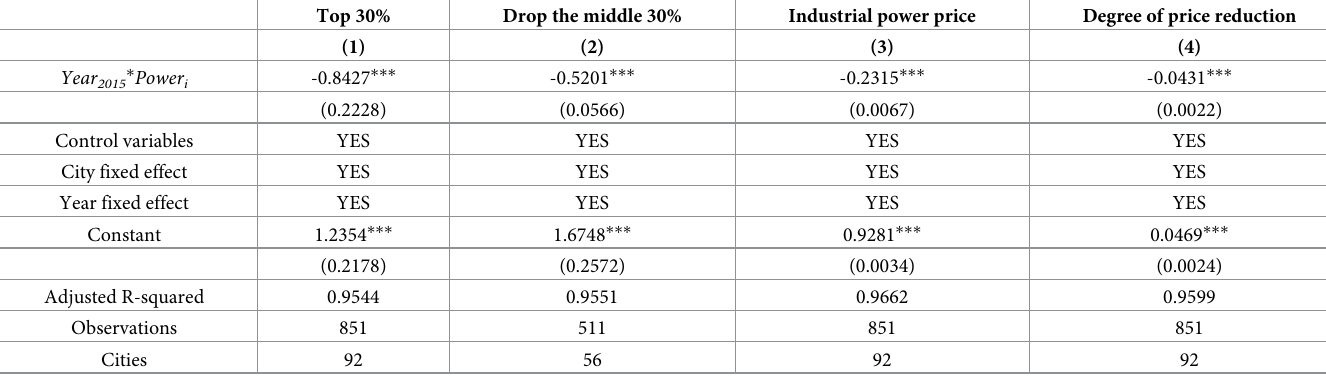
Table 4. Robustness test based on the setting of treatment